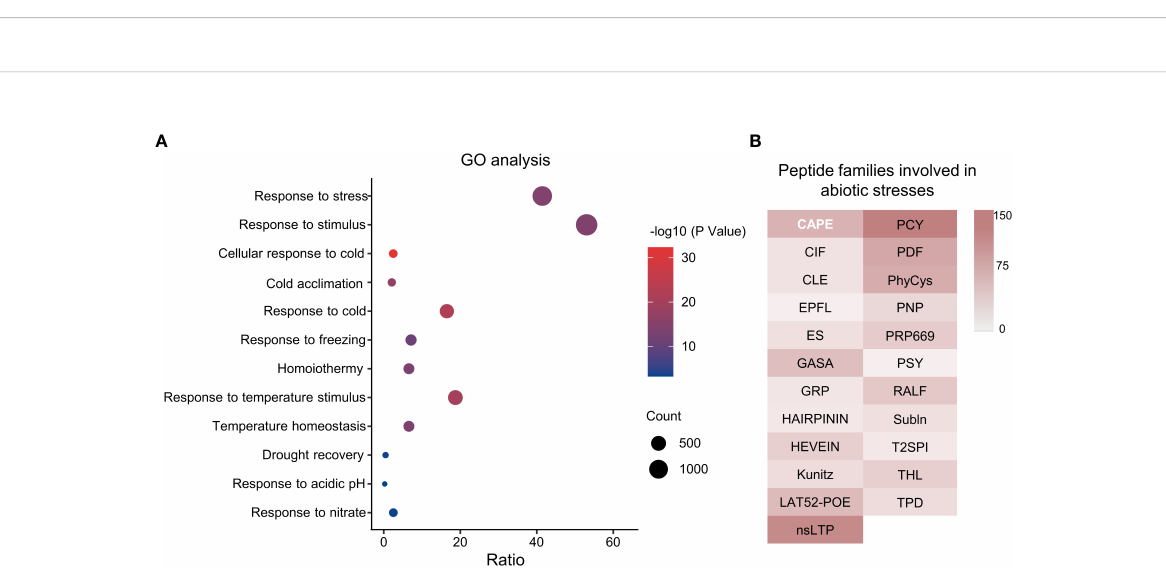
FIGURE 5 GO analysis of wheat SSPs. (A) Go terms involved in stress response. X-axis represents Gene Ratio of genes in each GO Terme to total gene numbers, Y-axis is GO Terms. The size of dots indicates the number of genes, and the color indicates P value. (B) Peptide families involved in abiotic stress response based on GO analysis. The color gradient indicates the number of